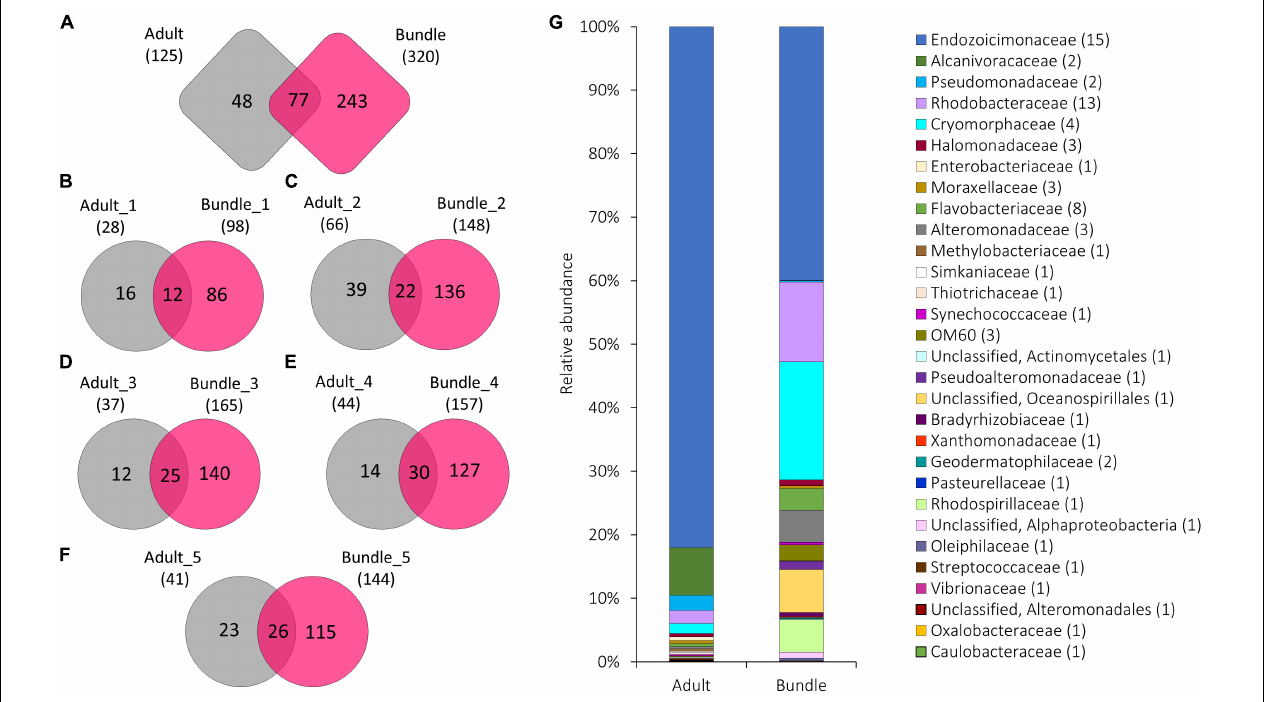
FIGURE 2 | The number of OTUs unique to or shared between (A) all five maternal coral colonies (adult) and the released egg-sperm bundles (bundle), and between each individual coral colony and resulting bundles (B–F) . The total number of OTUs associated with each group is represented in parentheses. Relative abundance of the 90 bacterial OTUs shared among adult colonies and egg-sperm bundles (G) (represented in A ). Sequences were classified at family level where possible, with unclassified sequences indicated at higher taxonomic resolution. Numbers in parenthesis demark the number of different OTUs within the respective